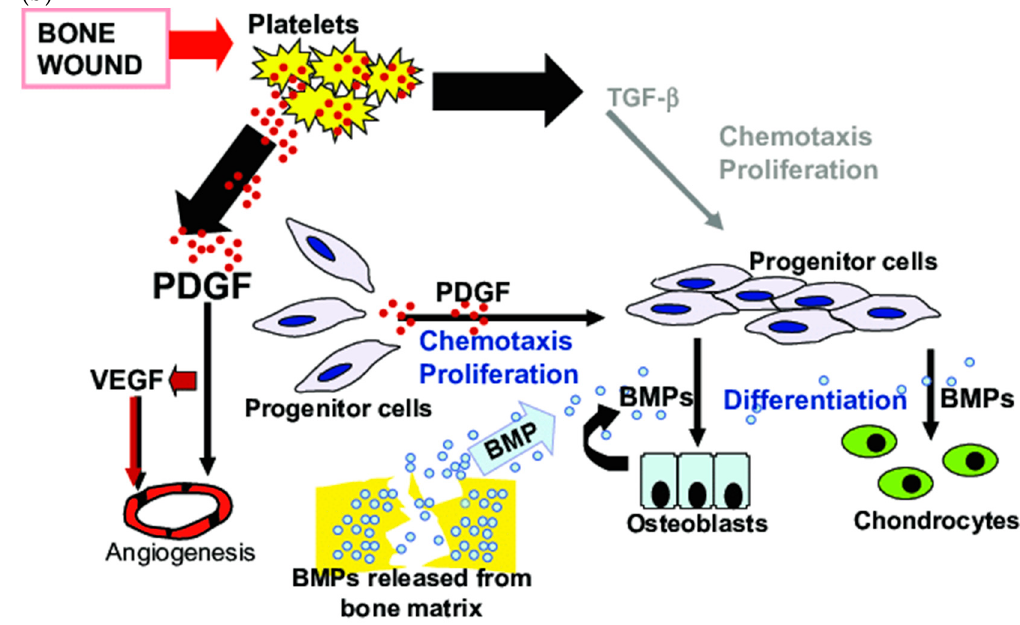
Figure 1. ( a ) Extraction socket-healing process. (BC, blood clot; B, buccal; L, lingual; PM, provisional matrix. WB, woven bone; BM, bone marrow; H&E staining; original magnification 16 × ). Reproduced with permission from Araujo et al. [4]. Copyright © 2005. John Wiley and Sons. ( b ) Growth factors related to bone wound healing. (PDGF, platelet-derived growth factor; VEGF, Vascular endothelial growth factor; BMPs, bone morphogenetic proteins; TGF- β , Transforming growth factor-beta) Reproduced with permission from Hollinger et al. [5]. Copyright © 2008. Wolters Kluwer Health, Inc.